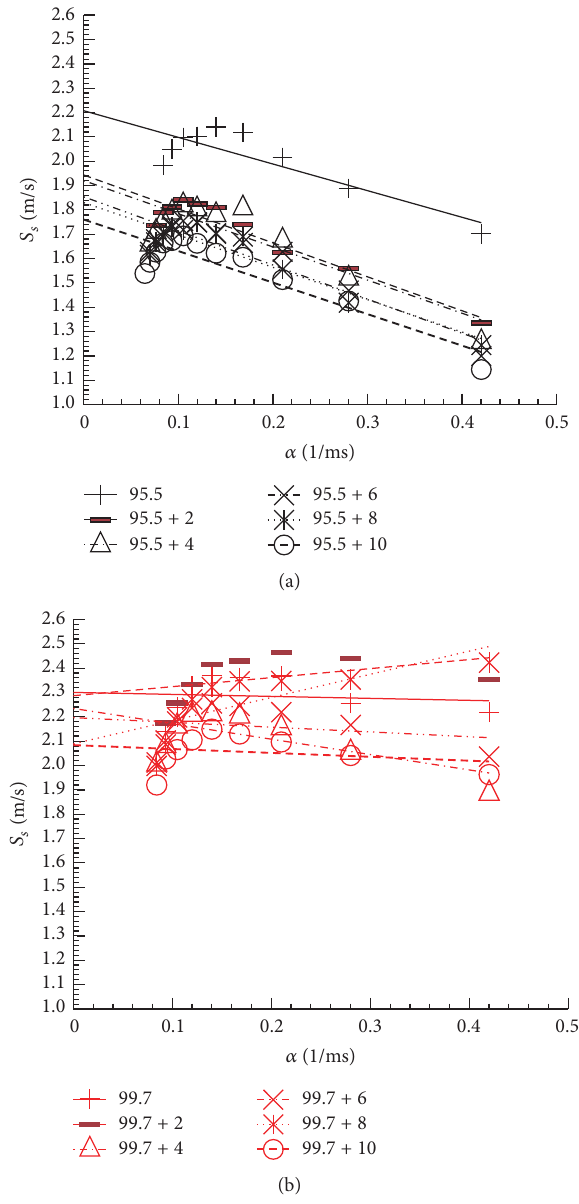
Figure 6: The flame speed for the stretch at 𝜙 = 1 . (a) Hydrous ethanol is added with n-heptane. (b) Anhydrous ethanol is added with